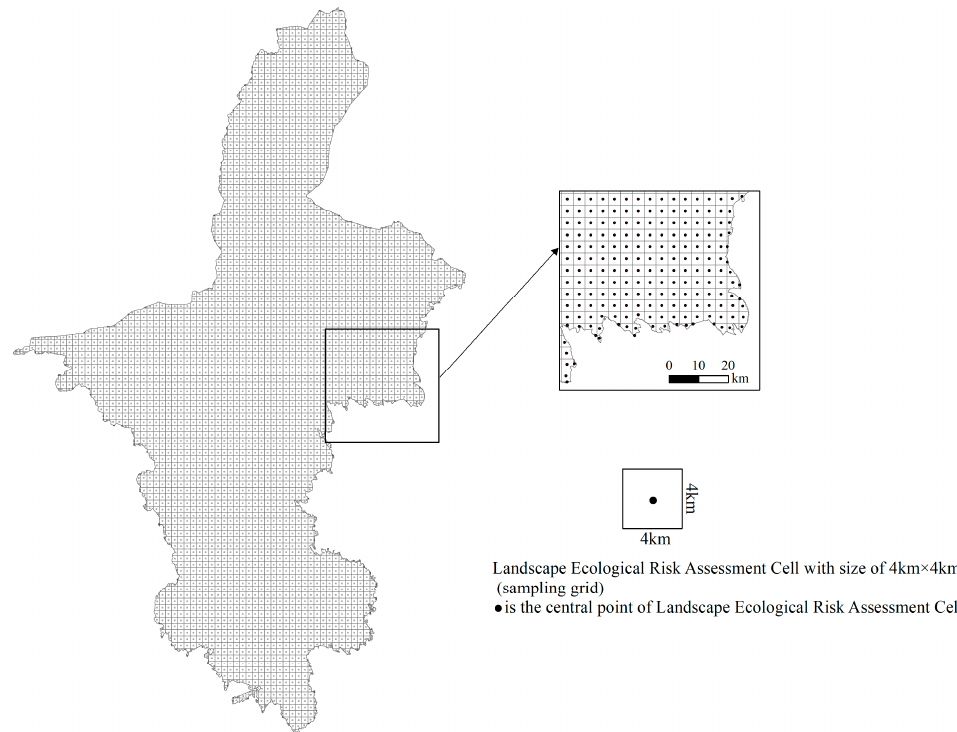
Figure 2. Division of LER assessment units.